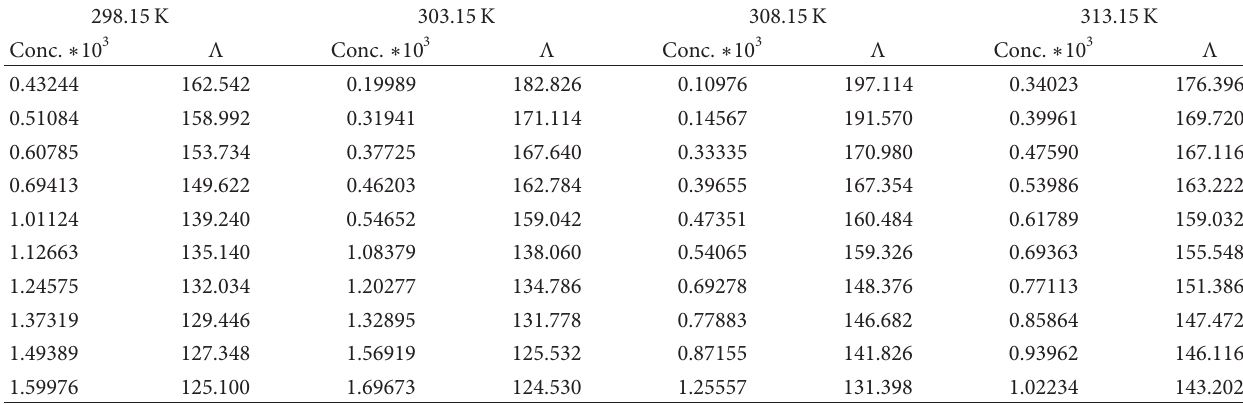
T 4: Experimental conductance data for Mn-succinate.